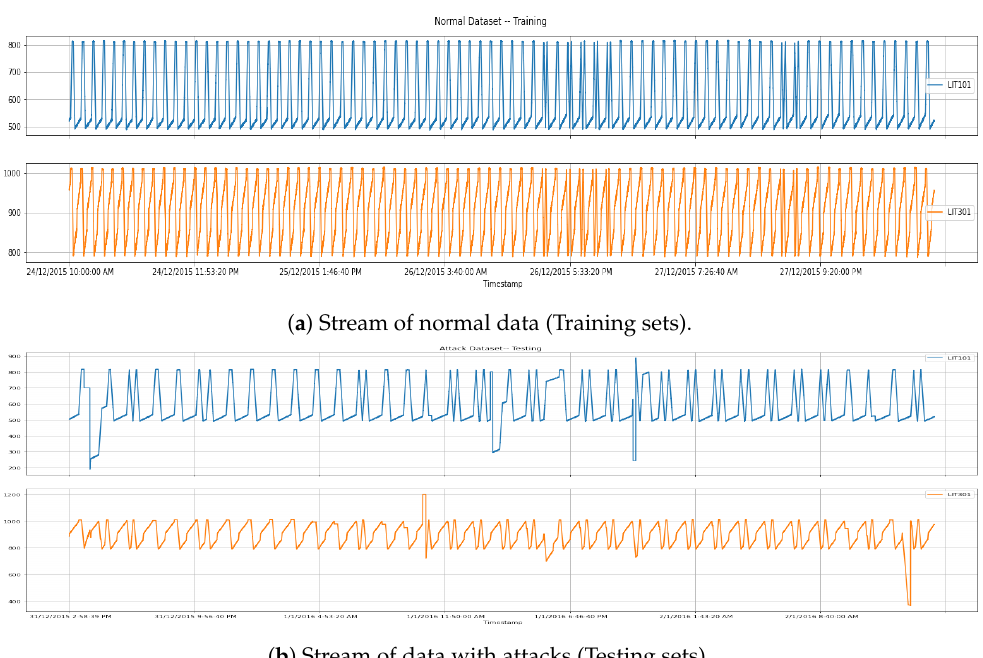
Figure 1. visualization of Training and Testing LIT-101 and LIT-301